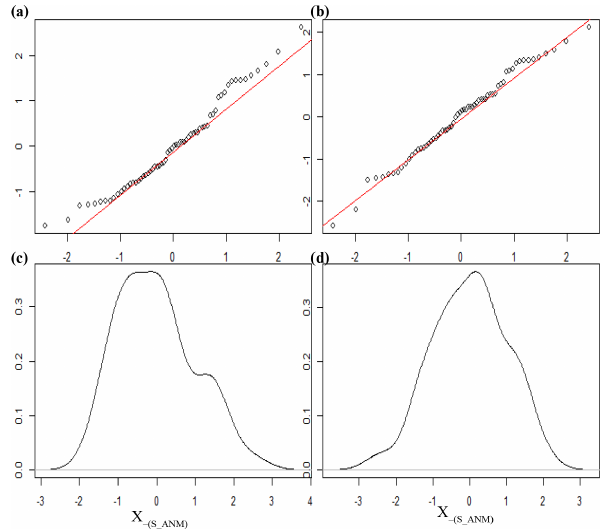
Figure A1. Manampitiya NEM standardized data. (a) Original form qqplot, (b) square root form qqplot, (c) original form density plot, and (d) square root form density plot.